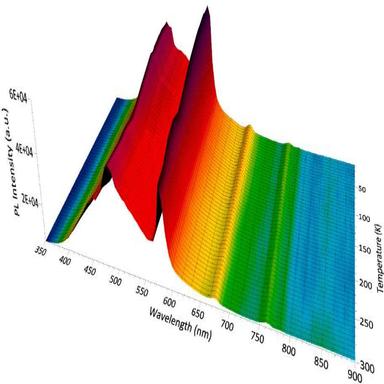
Variation of PL spectrum of ZrO2:0.004Dy3+ phosphor sample with temperature.